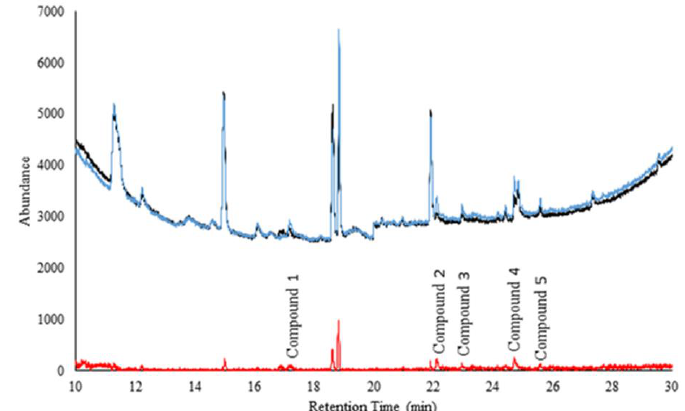
Figure 2. Comparison of averaged ‘sick’ and ‘healthy’ cattle serum samples. The black is the average of all 50 ‘healthy’ cattle samples. The blue is the average of all 50 ‘sick’ cattle samples. The red is the standard deviation between the ‘sick’ and the ‘normal’ cattle samples (to visualize the presence of probable markers).